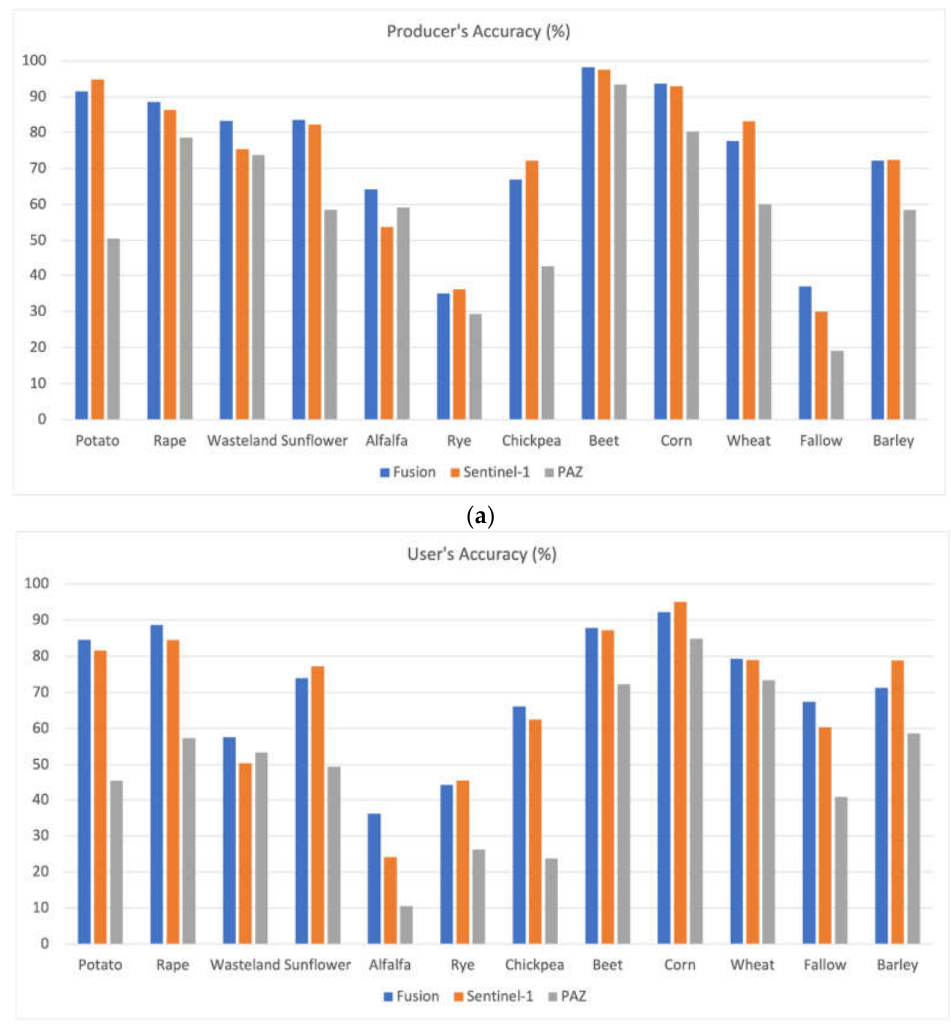
Figure 5 . PA and UA bar charts with 40 Sentinel-1 images and 8 PAZ images, both independently and with fusion. ( a ) Producer’s accuracy. ( b ) User’s accuracy.